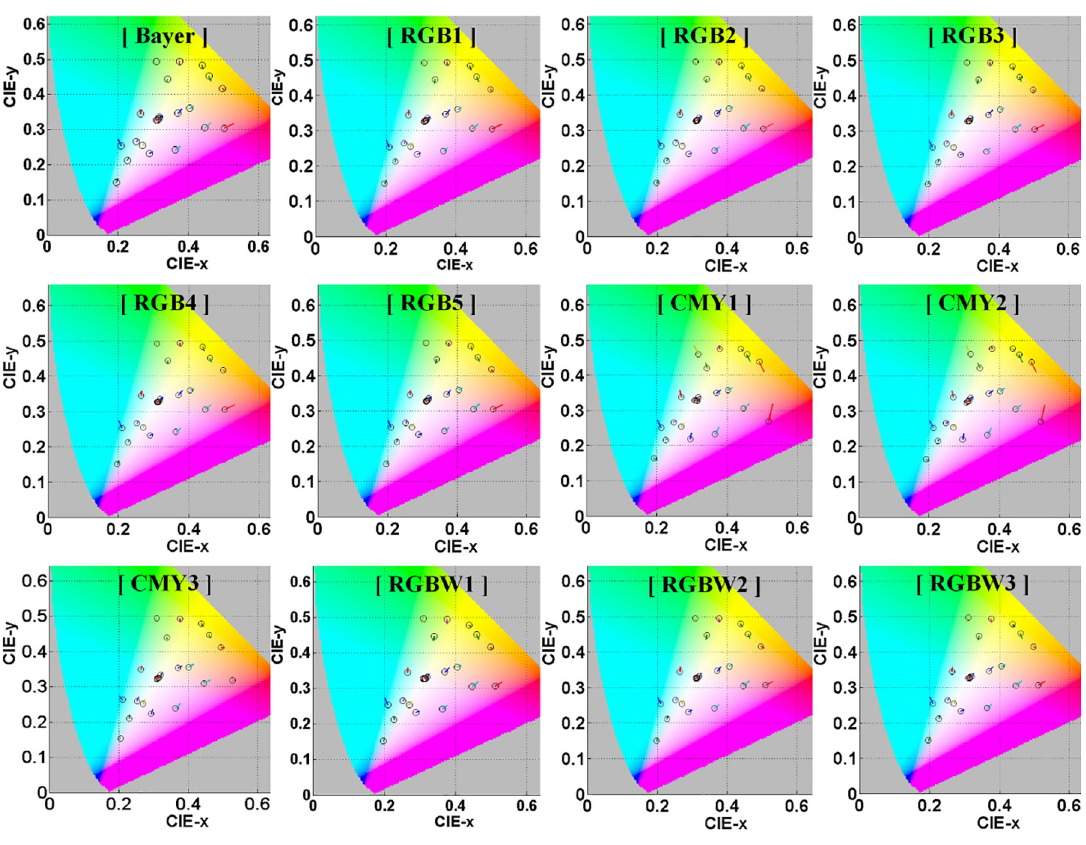
Fig 9. xy chromaticity diagram of test CFAs for